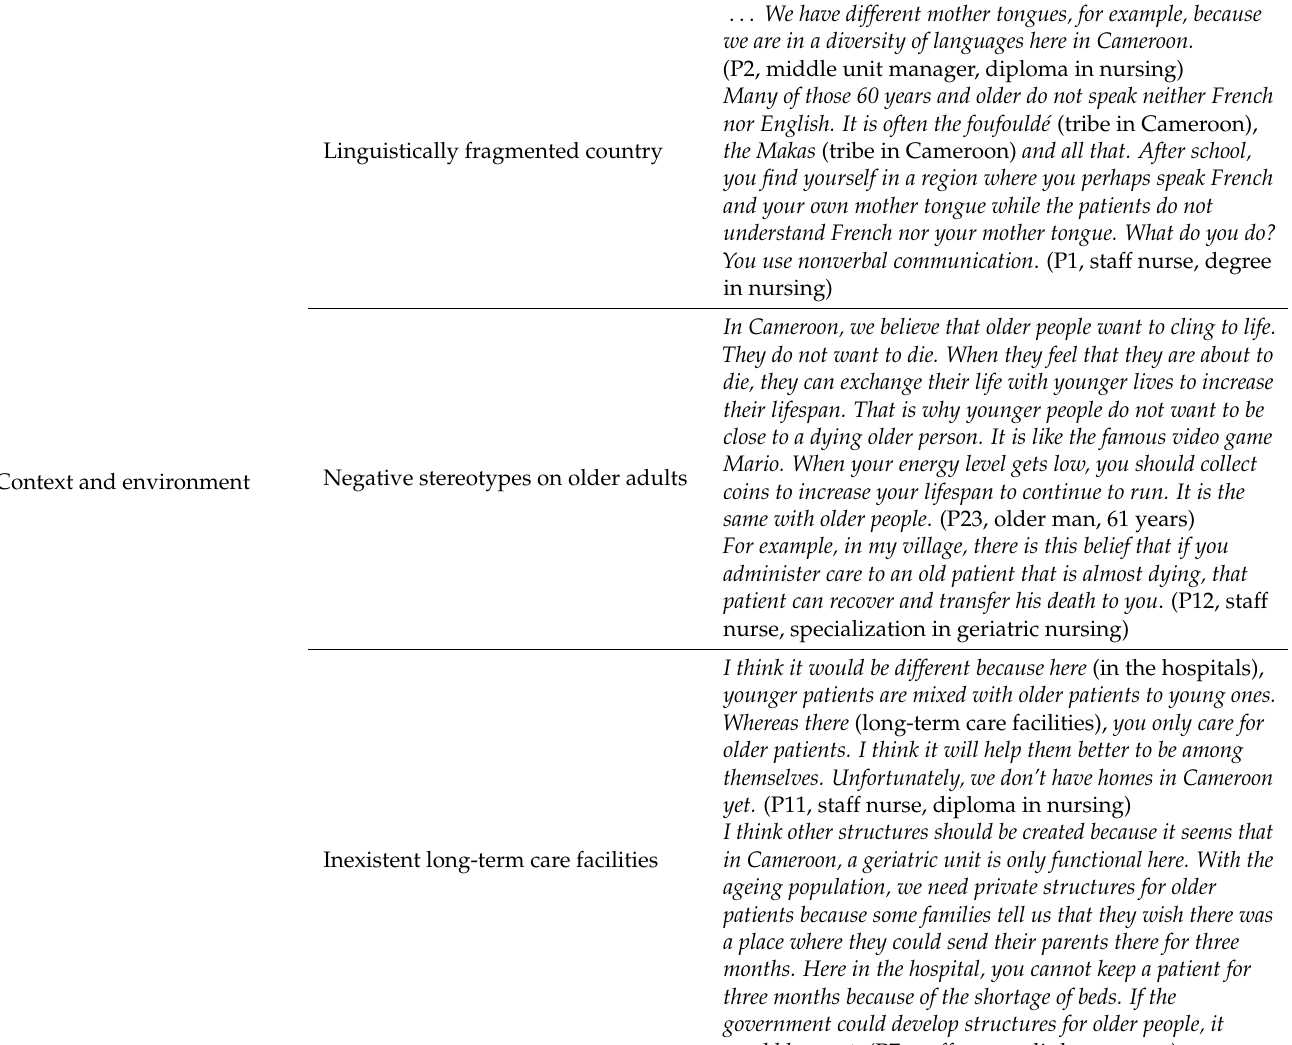
Table 2. Extracts of the contextual conditions forming the basis for developing the model.